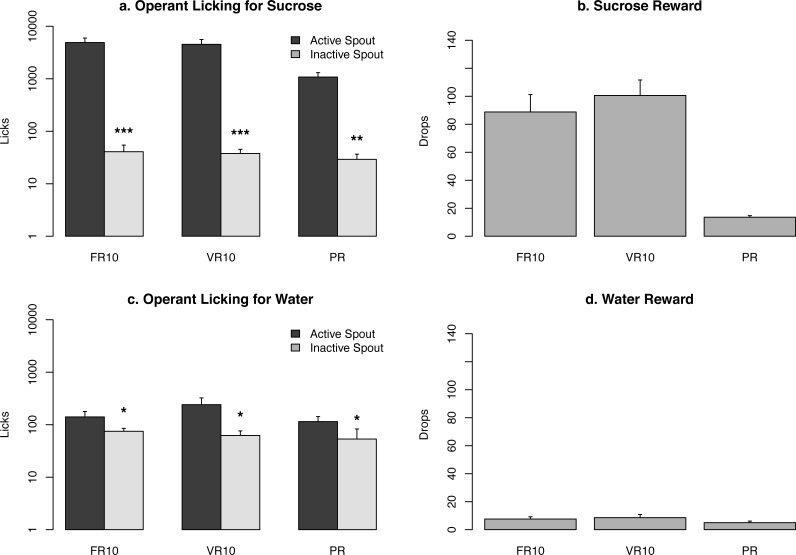
Summary of lick responses and rewards.Ten rats were tested using the operant licking devices to obtain a sucrose solution (10%, n = 5) or water (n = 5) under the control of a fixed ratio 10 (FR10), a variable ratio 10 (VR10), or a progressive ratio schedule (VR). A logarithmic scale is used for the Y-axis for (A and C). *p < 0.05 , ***p < 0.001 , compared to the active spout.